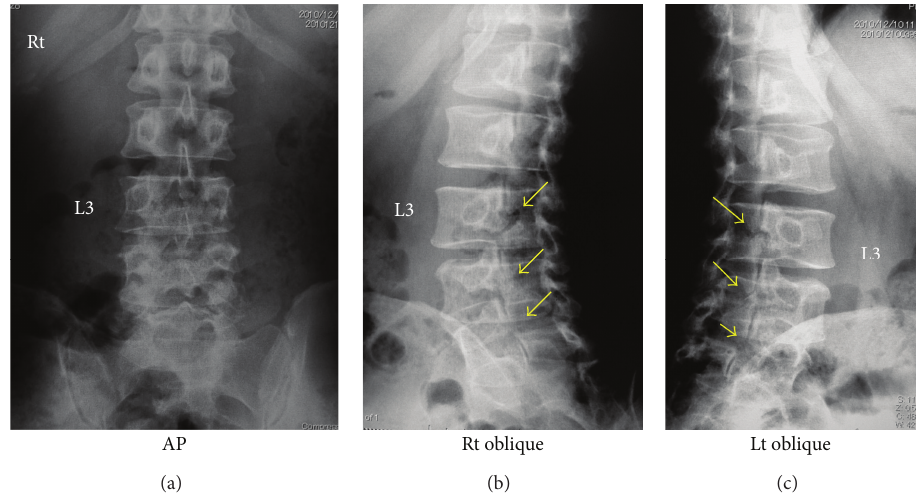
Figure 1: Plain anteroposterior and oblique radiographs at initial presentation show bilateral lumbar spondylolysis at L3–5.